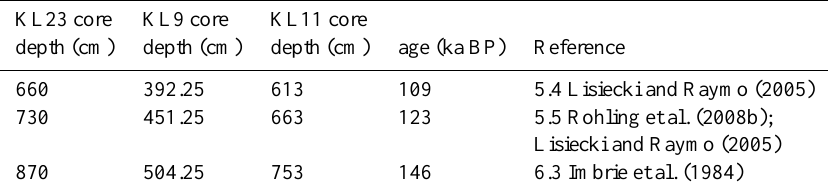
Table 1. Age model tie points of the observed Red Sea cores.